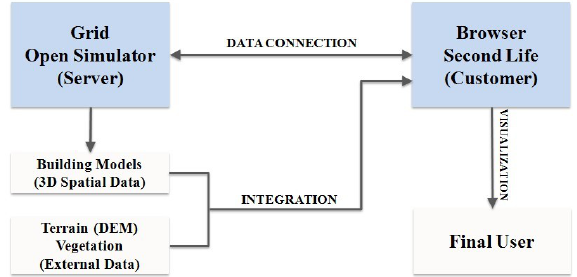
Figure 1. Inner Structure of OpenSim – The VGE Platform Used in this